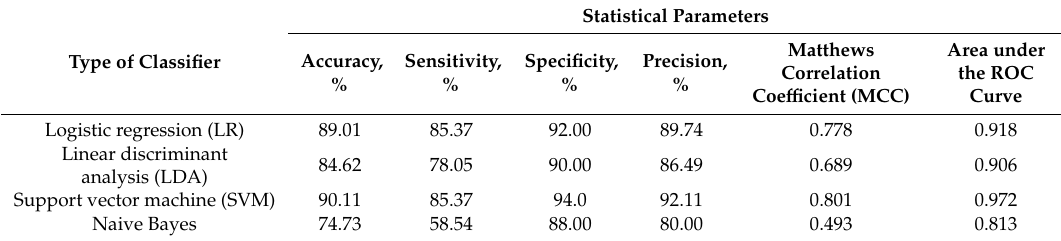
Table 2. Performance of classifiers by combining optical dermatoscopy and spectrophotometry imaging techniques to classify cutaneous melanoma (CM) and melanocytic naevus (MN).